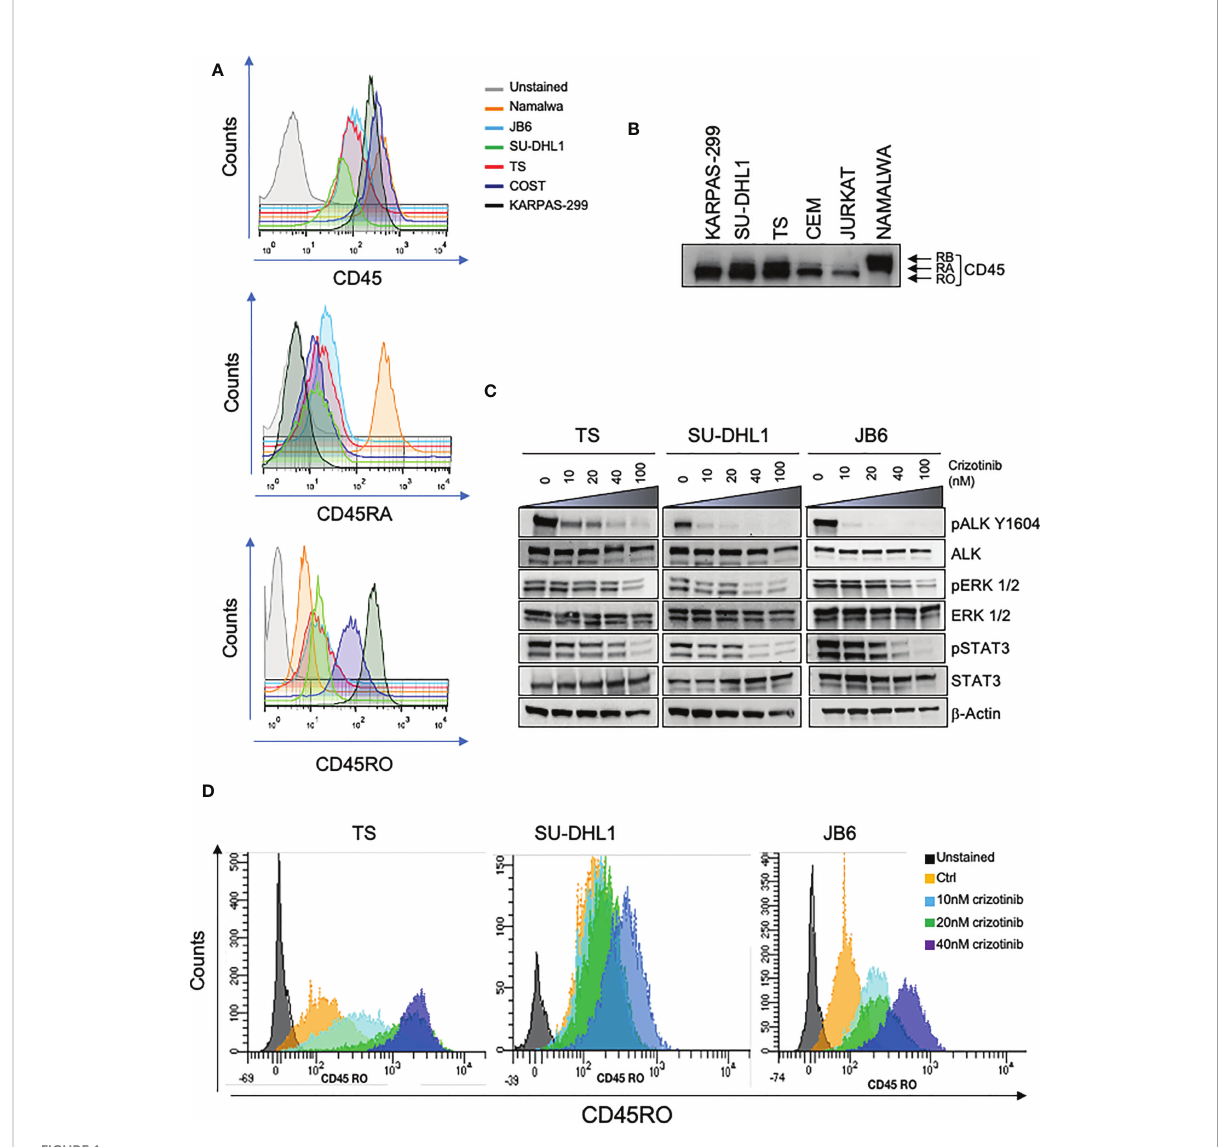
FIGURE 1 CD45 is expressed in ALK+ ALCL cells. (A) CD45, CD45RA, CD45RO basal cell surface expression in ALK + ALCL cells (TS, SU-DHL1, JB6, COST and KARPAS-299) and in Burkitt Lymphoma cells (NAMALWA) measured by fl ow-cytometry. A representative experiment out of three is shown. (B) Immunoblot analysis performed on human ALK+ ALCL cells lines and Burkitt lymphoma cells (NAMALWA), Lymphoblastic cells (CEM), T acute lymphoblastic leukemia cells (JURKAT) blotted with the indicated antibodies. A representative experiment out of two is shown. (C) Immunoblot analysis on three representative ALK+ ALCL human cell lines (TS, JB6 and SU-DHL1) treated with increasing concentrations of ALK inhibitor crizotinib for 3 hours. Cell lysates were blotted with the indicated antibodies. (D) CD45RO cell surface expression intensity measured by fl ow-cytometry in ALK+ ALCL cell lines treated with the indicated concentrations of crizotinib for 96 hours. The experiment and Western blot were performed one time on three independent cell lines with similar